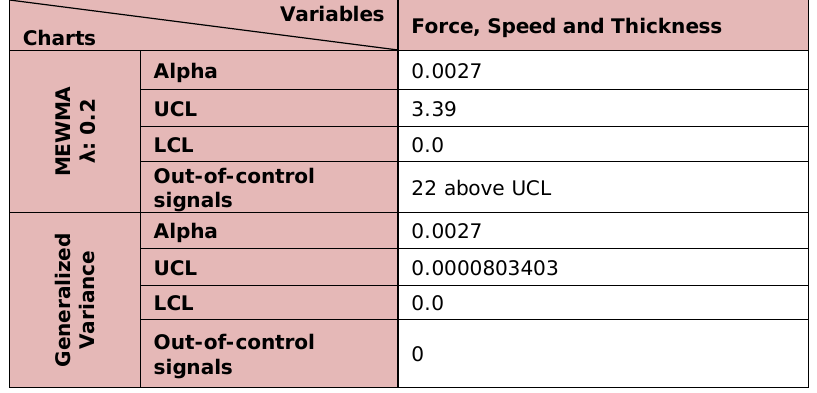
Table 9. “MEWMA and generalized variance charts parameters for primary